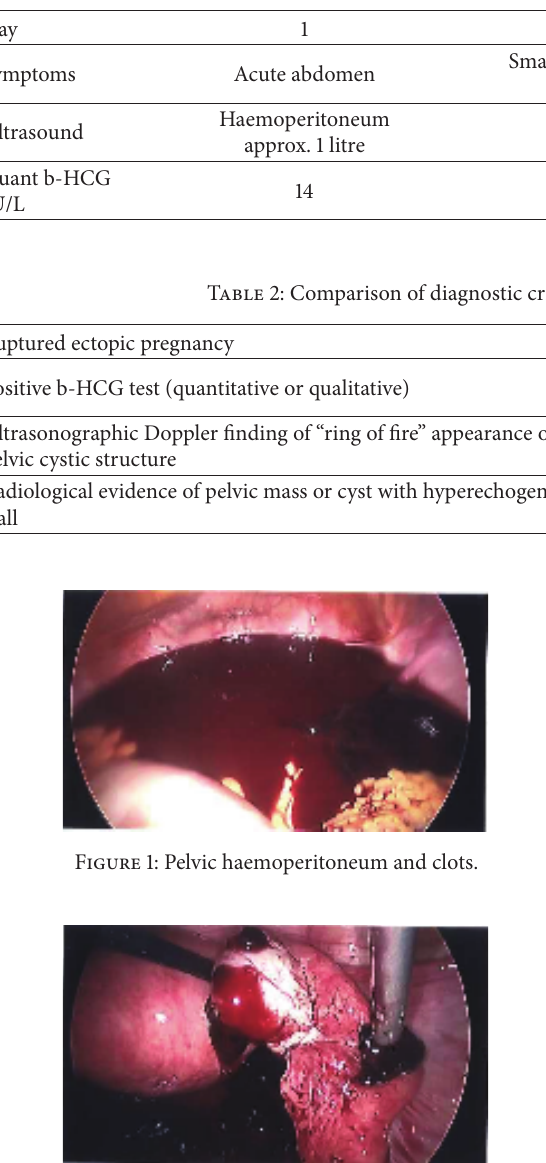
Table 1: Summary of timeline and investigations.